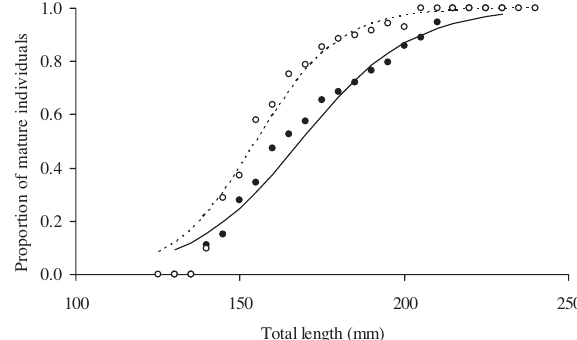
F IG . 5. – Estimated (line) and observed (dots) proportion of mature at length (L, mm) round sardinella, Aegean Sea (females: solid circles, males: open circles).